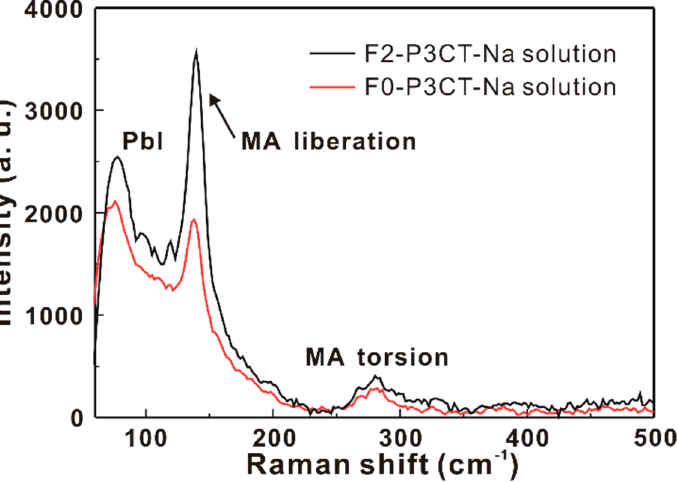
Figure 11. ( a ) Wavelength-dependent fill factor and ( b ) wavelength-dependent power conversion efficiency (PCE) of the P3CT-Na based MAPbI 3 solar cells under a low light intensity of 4 mW.